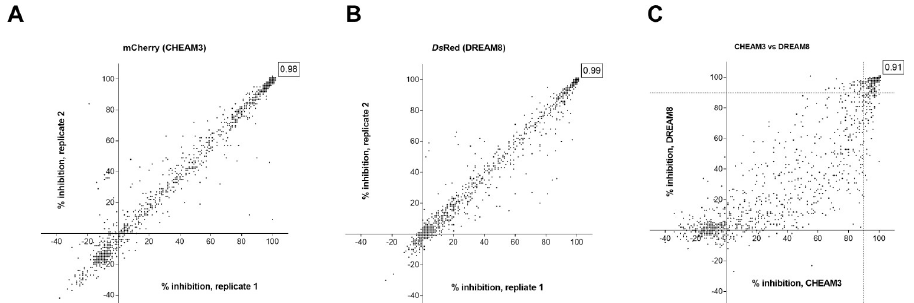
Fig 4. Small molecule compound library screen: A selected library of 1105 small molecules from NIH-SRI/TAACF was screened in replicate experiments against (A) CHEAM3 or (B) DREAM8. The % inhibition for each compound was calculated. The results from the first and second runs are plotted on the x- and y-axis, respectively, for both strains. For each strain the Pearson coefficient of linear correlation between the two replicate data sets was calculated in Graphpad Prism and is shown in boxed text in the upper right corner of each plot. (C) The average % inhibition of CHEAM3 and DREAM8 growth was calculated and plotted on the x- and y- axis, respectively. The calculated Pearson co-efficient comparing the data generated from the two different strains is shown in boxed text in the upper right corner of the plot.